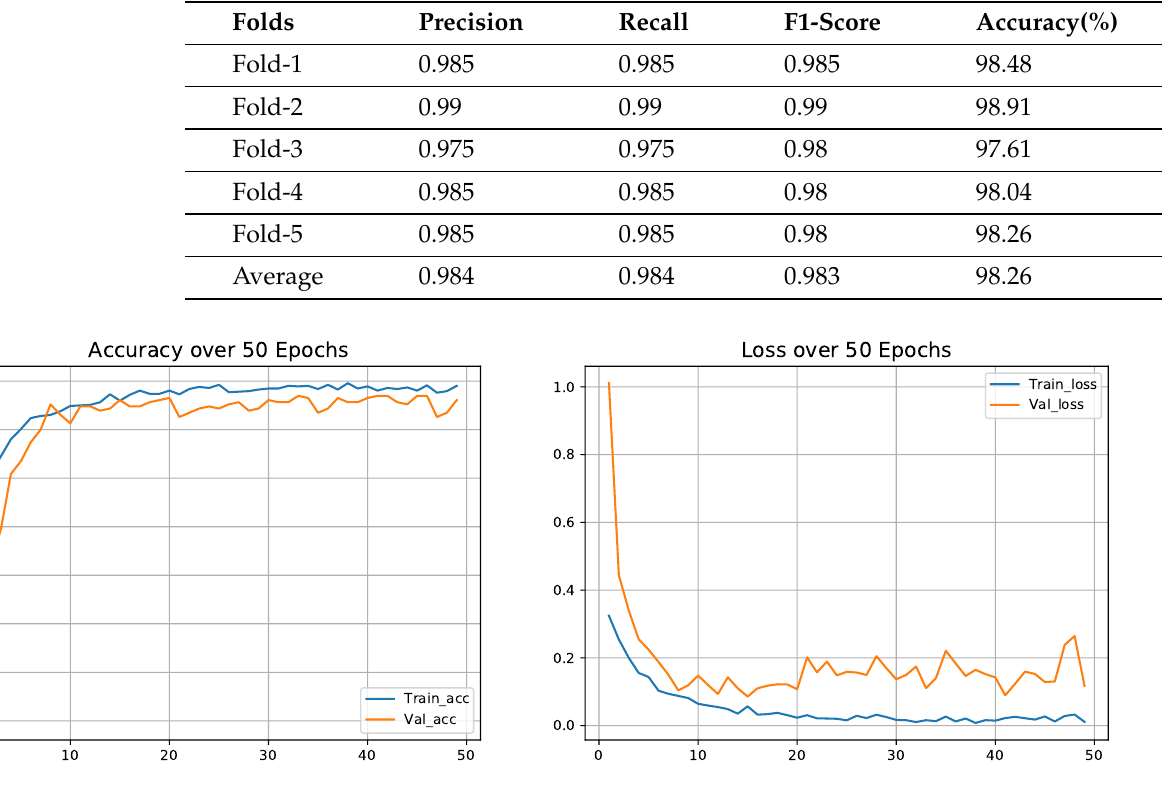
Figure 10. Accuracy and loss curve results on fold-5 of